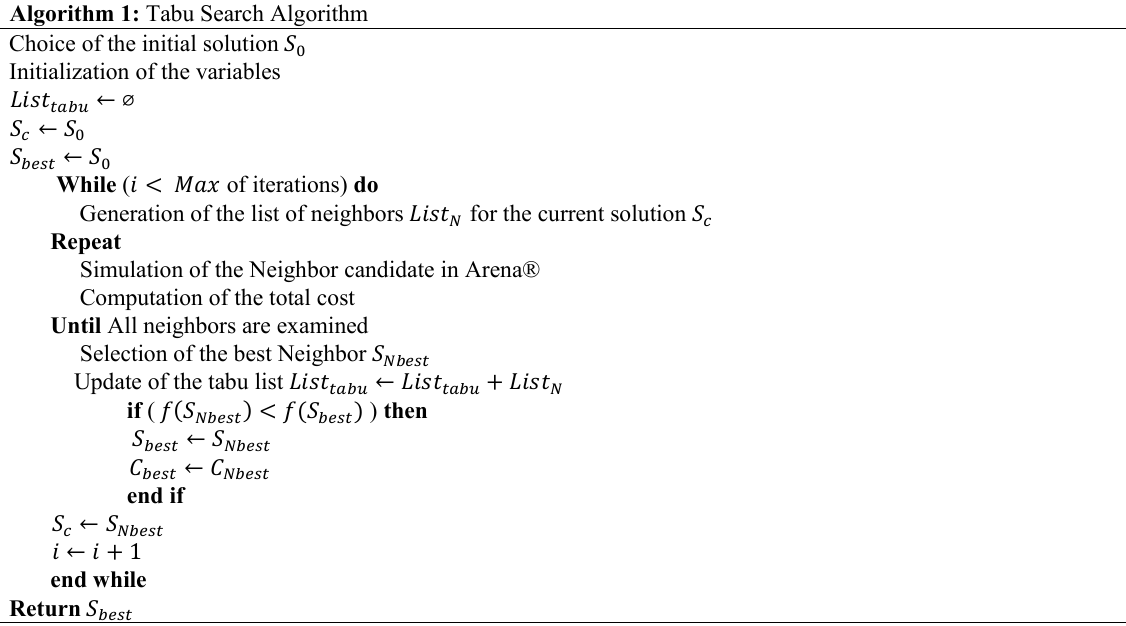
Algorithm 1: Tabu Search